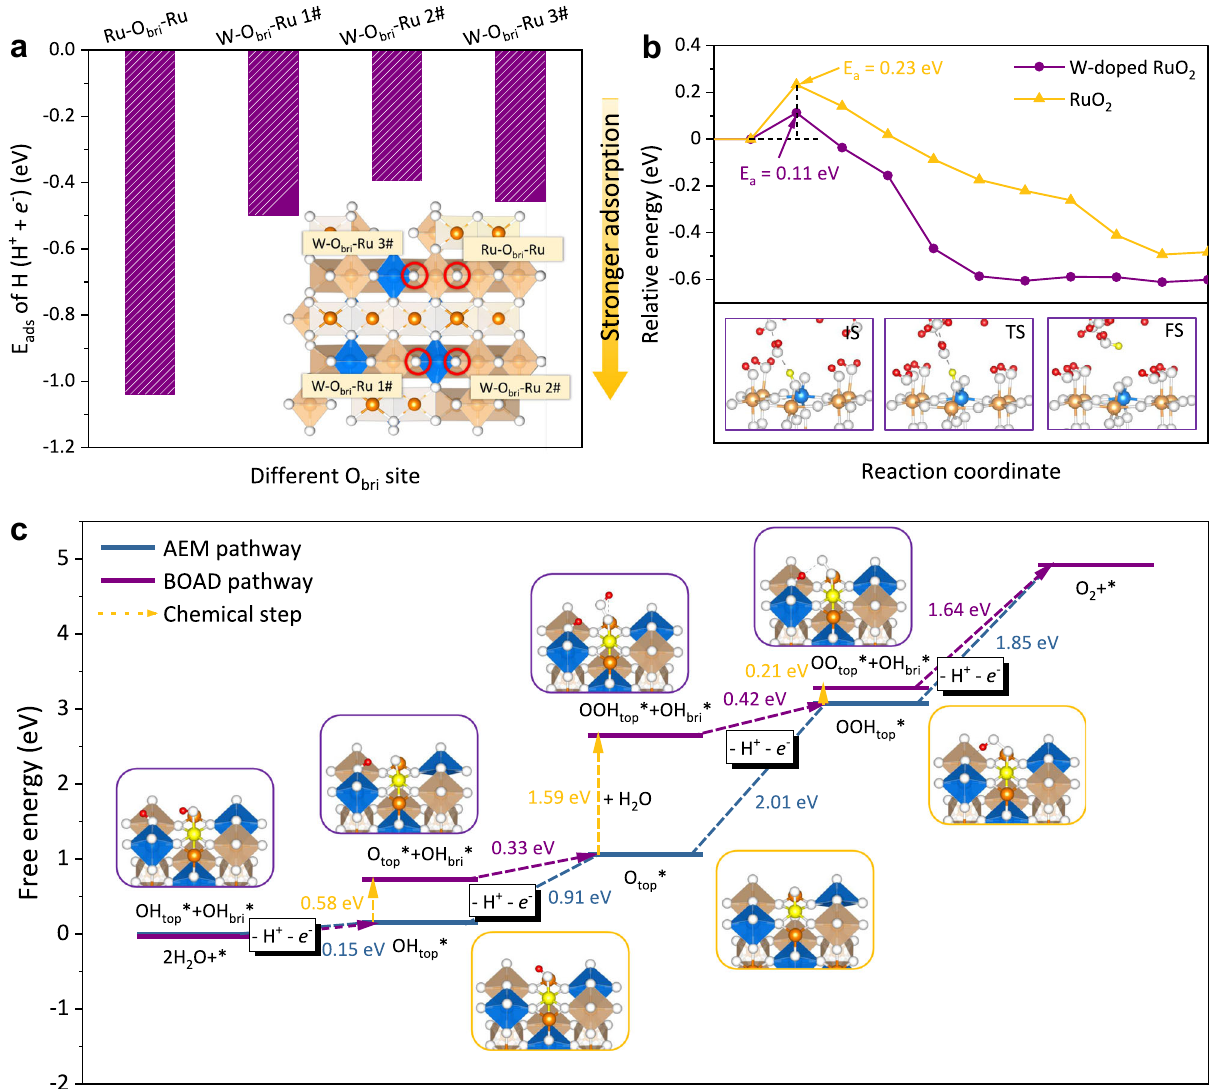
Fig.5|DFTinvestigationofhydrogenadsorptiononRu-Wbinaryoxides.a The H atom adsorption energy on different surface O bri sites. Inset: Schematic of dif- ferentO bri sitesontheW-dopedRuO 2 . b Thekineticbarrierofthedeprotonationof OH bri on different catalysts with solvent. Insets: The snapshots of the initial state